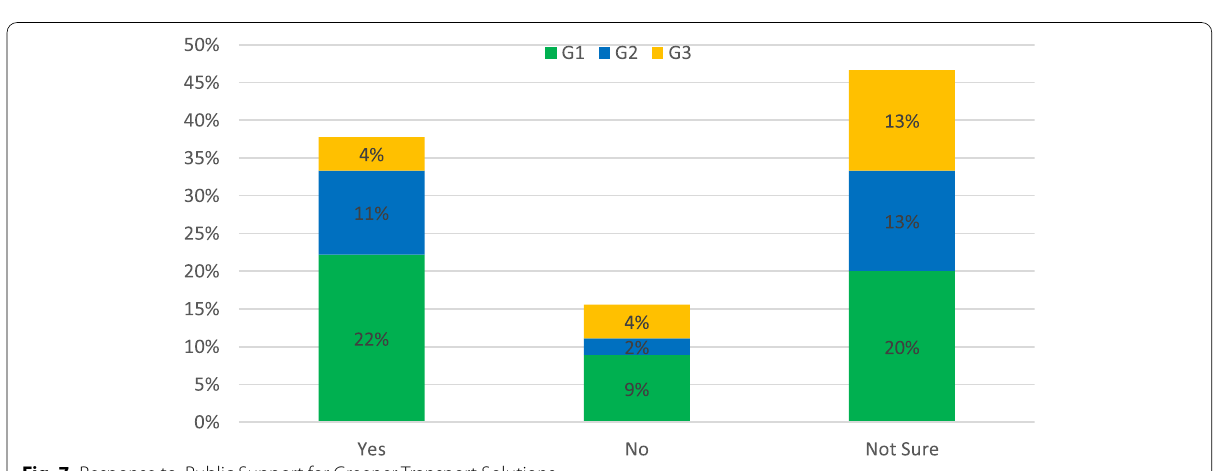
Fig. 7 Response to: Public Support for Greener Transport